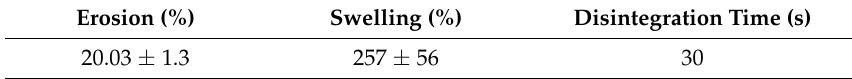
Table 3. Swelling and erosion behavior of CH films incorporated with peptide-loaded CH